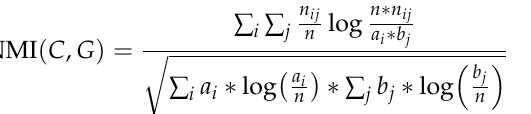
Figure 6. Adjusted Rand Index Comparison Using KDDCup’99, Landsat, Spiral, and DNA Da- tasets.